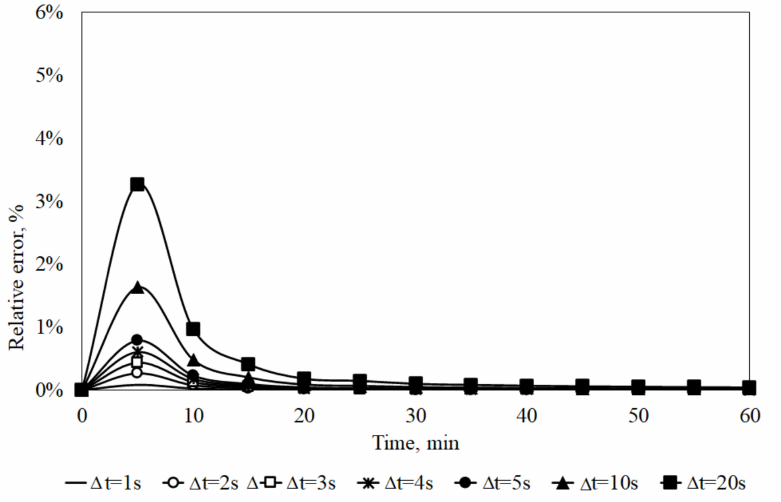
Figure 6. Relative error for use of LC method,